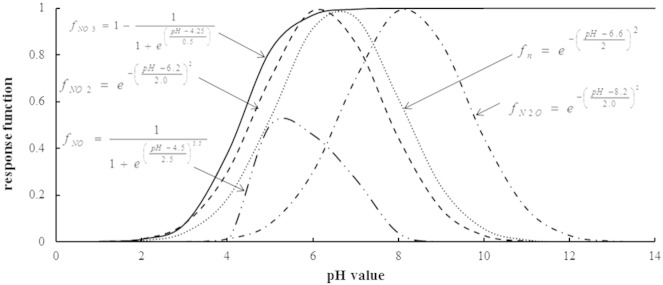
Response functions of nitrification (fN) and denitrification processes (fNO3: for nitrate denitrifiers; fNO: for NO denitrifiers; fNO2: for NO2− denitrifiers and fN2O: for N2O denitrifiers) to soil pH.